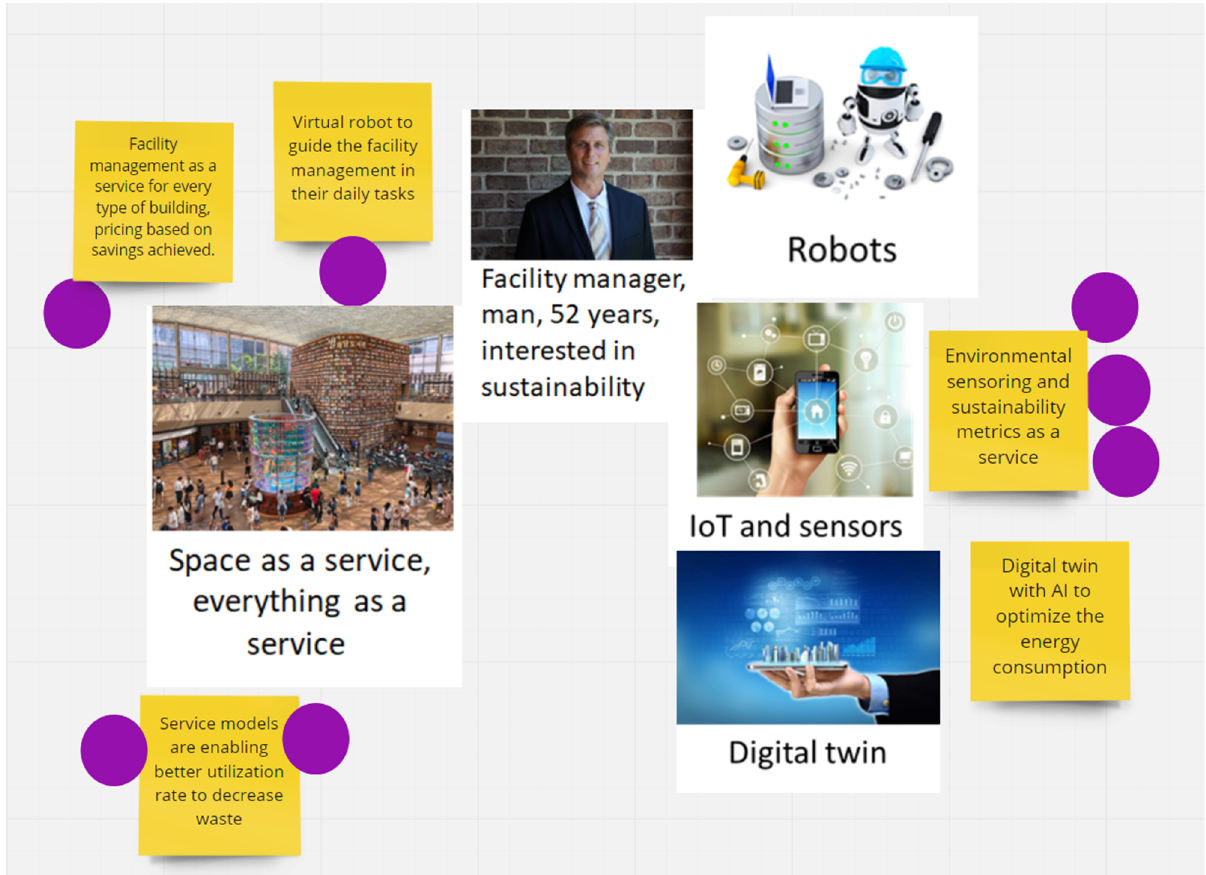
Figure 2. Example of the thematized ideation results and votes in Miro online Whiteboard (partial view of the whiteboard).